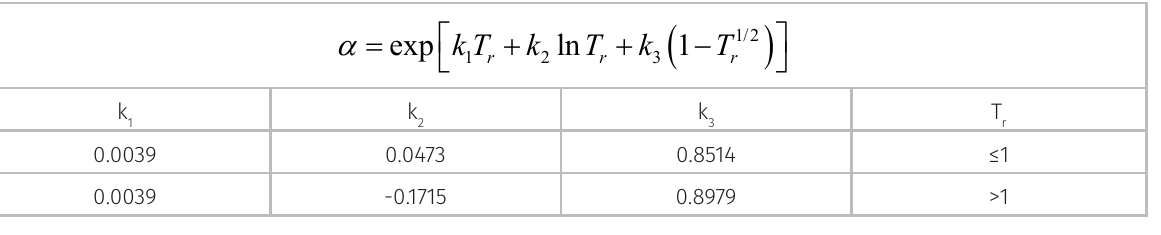
Table II. Parameters of the original and extended Saffari-Zahedi alpha function for